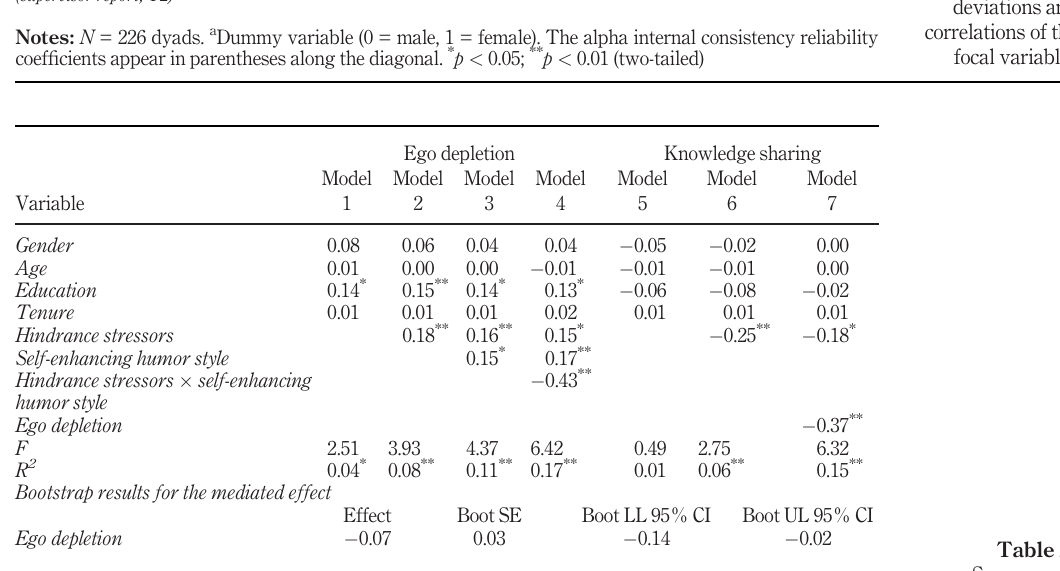
Table 2. Summary